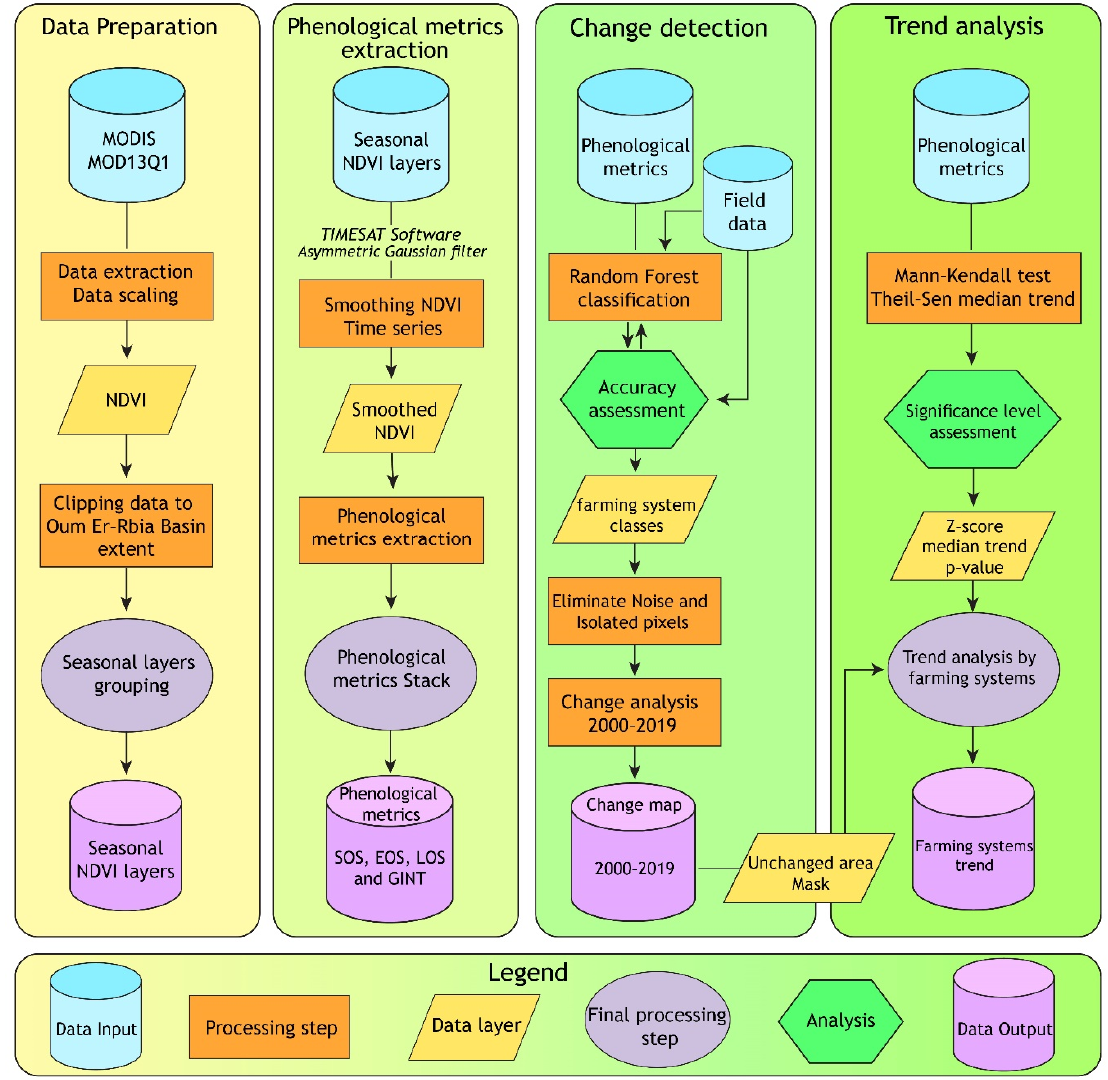
Figure 4. Overview of the methodology adopted in this study.